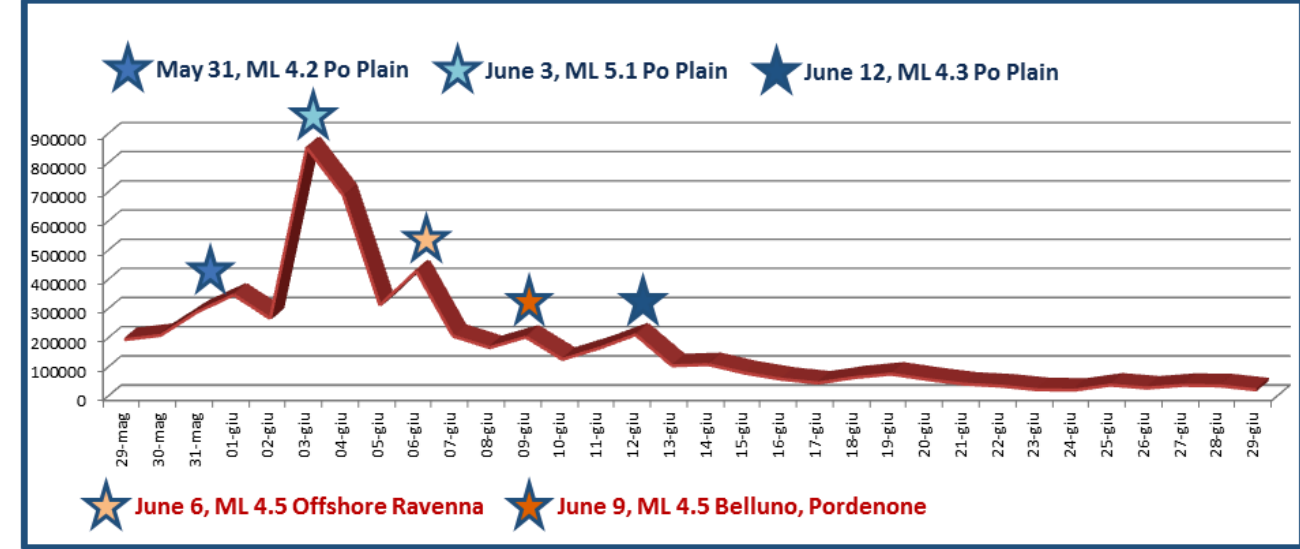
4.2 Po Plain event; the June 3, 2012, L 4.5 event L